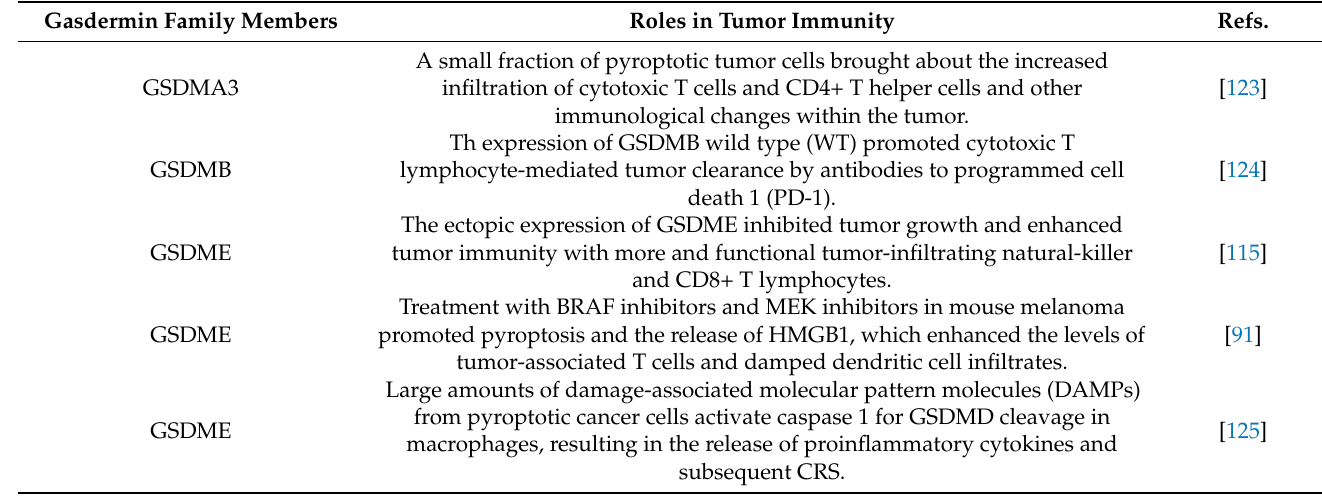
Table 3. Roles of gasdermin family members in tumor